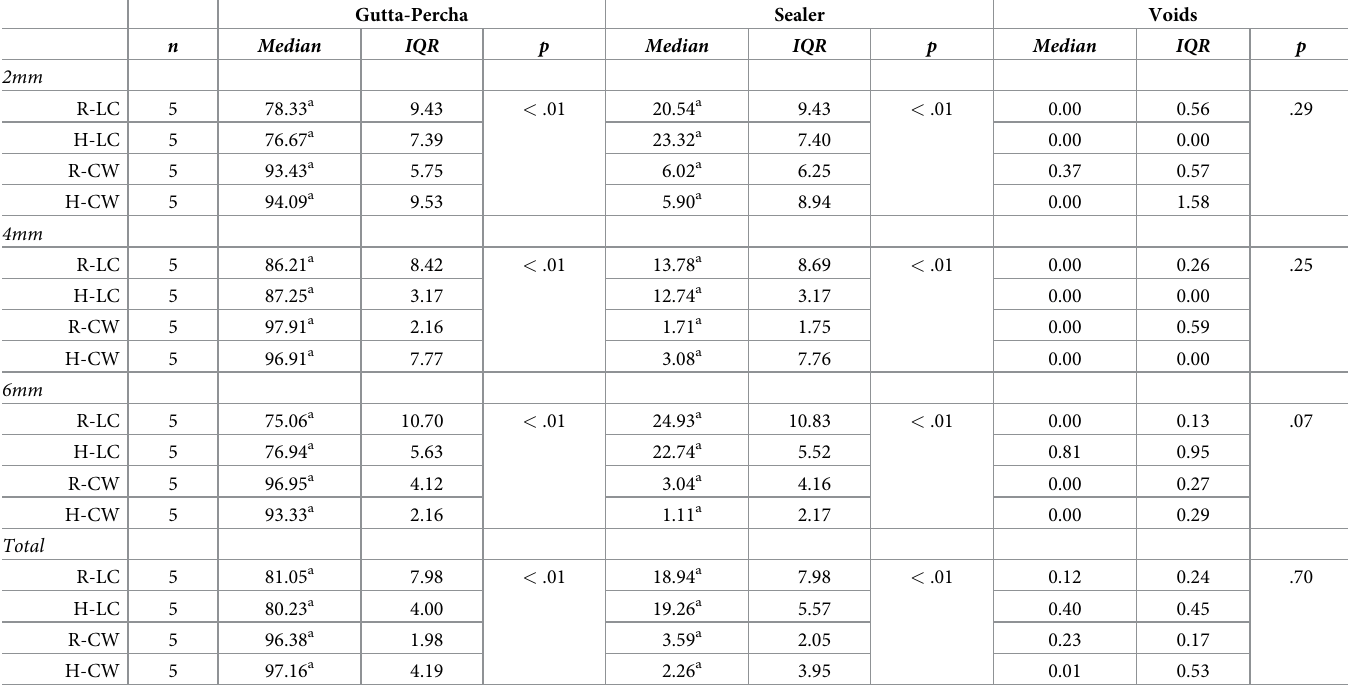
Table 6. Descriptive statistics and Kruskal-Wallis test results on the percentages of gutta-percha, sealer and voids according to level of sections in C2-type. Gutta-Percha